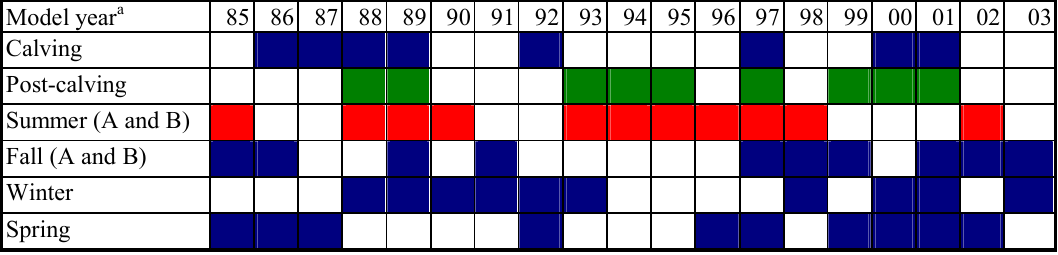
Figure A1.1 . Environmental conditions by season and year used for historical